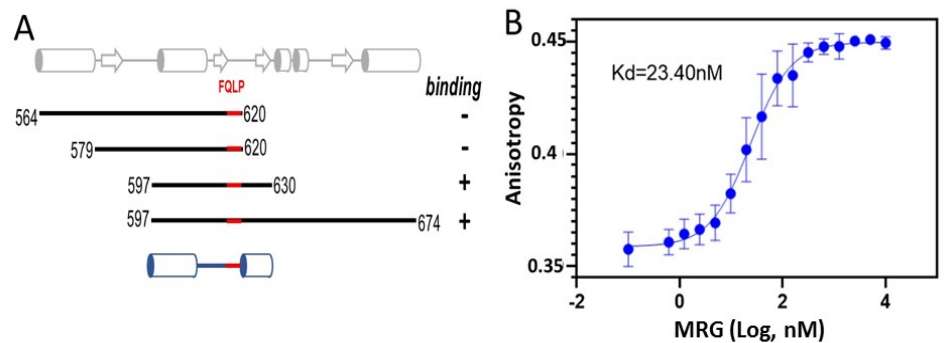
Figure 1. MRG interaction with PALB2. ( A ) Preliminary analysis of MRG binding by purified His- tagged PALB2 peptides represented schematically as black lines with numbers for N- and C-terminal amino acids shown at the ends and with the FQLP motif highlighted in red. Panel on top shows predicted secondary structure elements ( α -helixes as cylinders and β -strands as arrows). Panel on the bottom shows secondary structure elements observed in a crystal structure. ( B ) Anisotropy isotherm of FAM-PALB2 597 − 630 peptide titration of MRG.